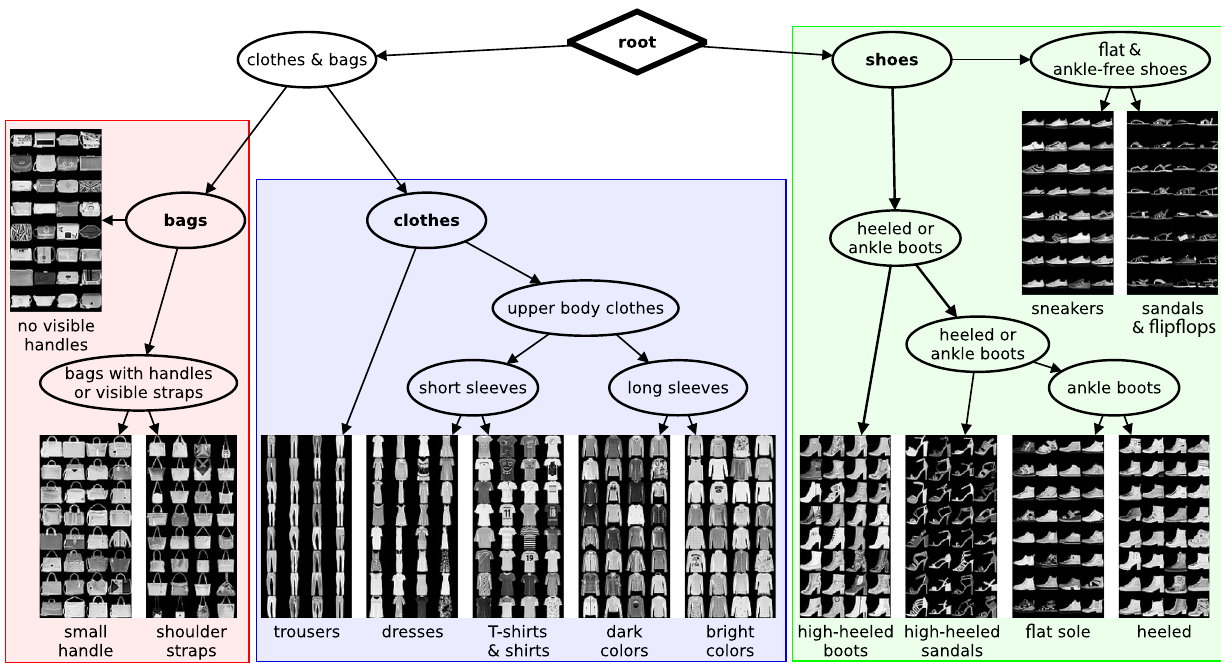
Fig. 7 The diagram shows a cluster tree for the Fashion-MNIST data- set. Each leaf node shows randomly sampled objects assigned to it. The labels are interpretations by the authors. The colored areas high-